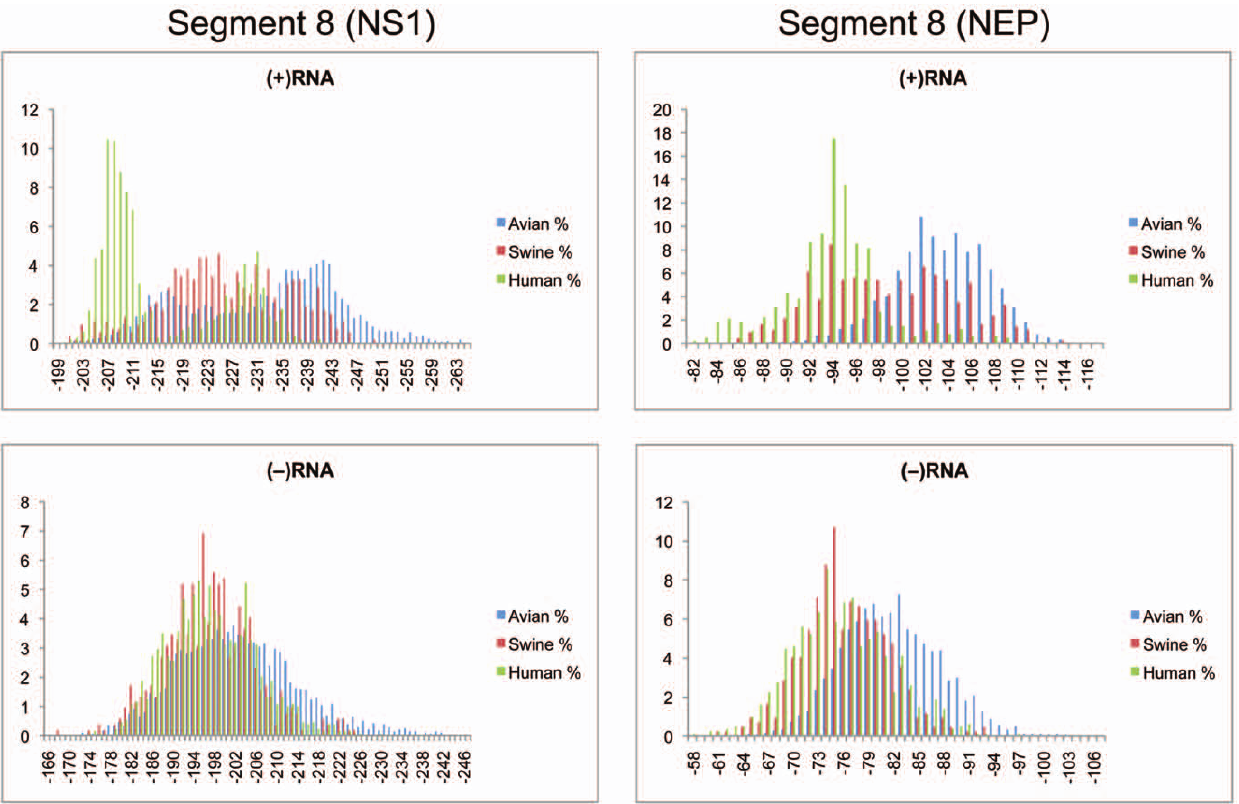
Figure 9. Predicted free energy distributions at 37 6 C for segment 8 coding regions. NS1 and NEP are shown in the left and right panels, respectively. ( + )RNA and ( 2 )RNA are shown in the top and bottom panels, respectively. See Figure 2 for annotations and